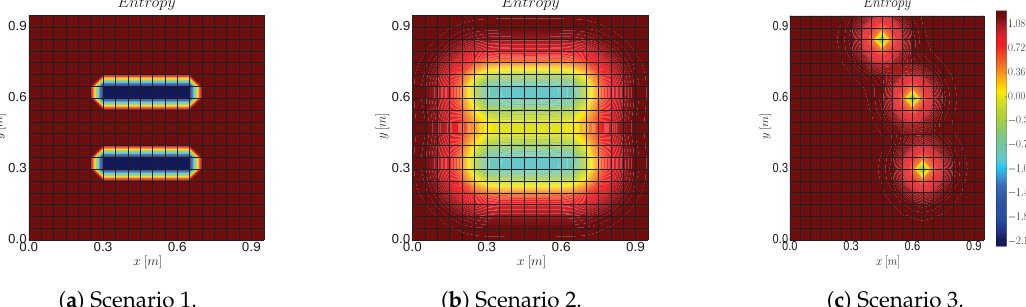
Figure 3. Simulation scenarios used to test the performance of Algorithm 3. We represent the entropy of the process after measuring at some spots. Scenario 1 and 2 correspond to two patches of measurements of processes that have a low and high spatial correlation, respectively. Scenario 3 corresponds to three measurements taken at random positions for each simulation run. In this latter case, we show just one